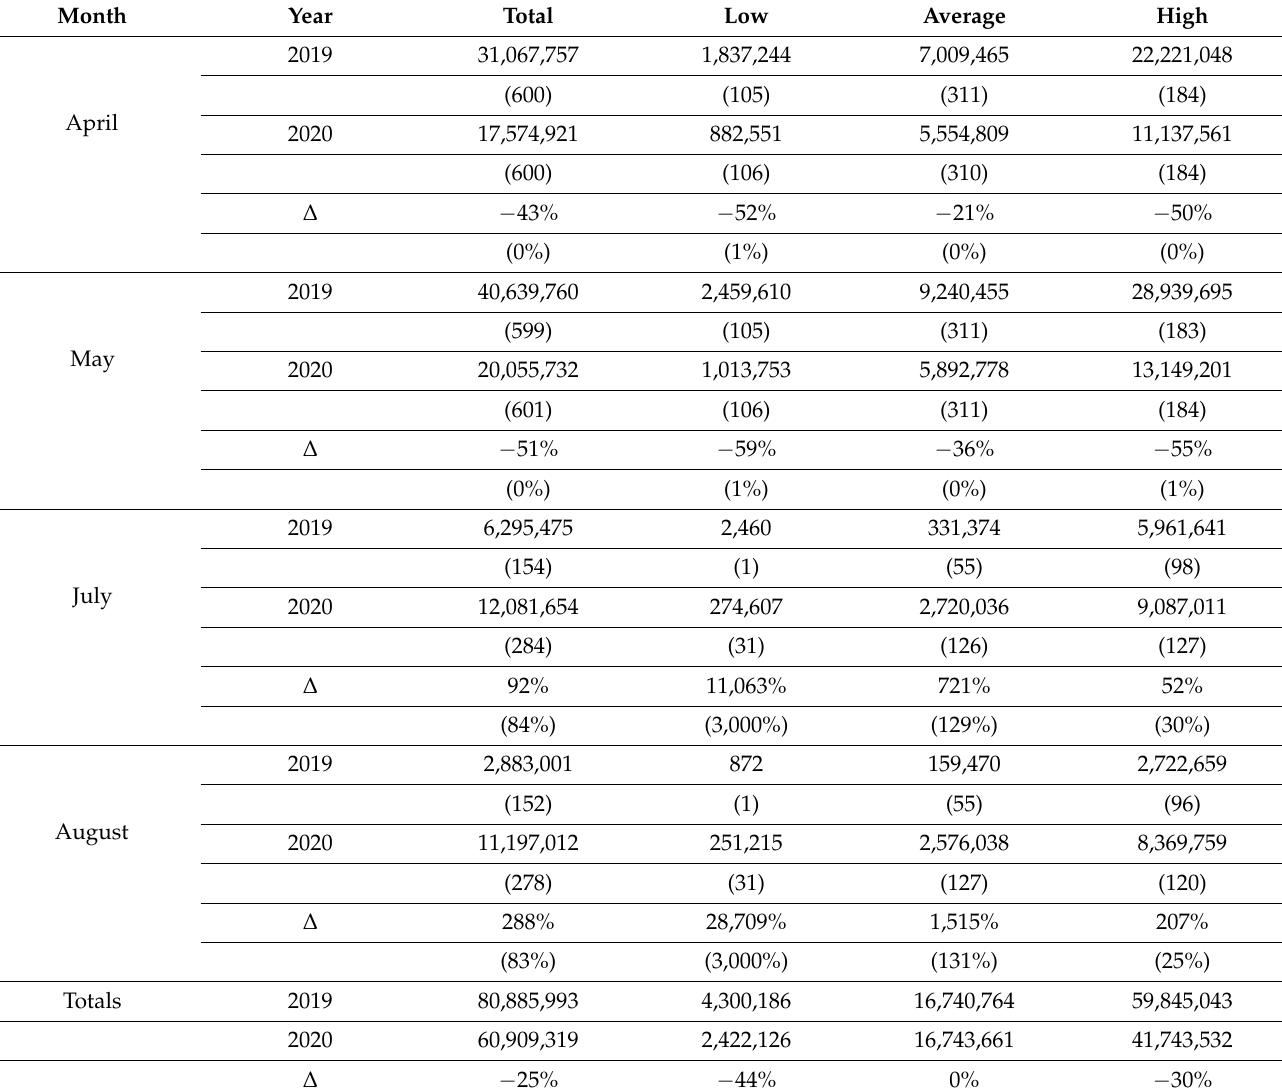
Table 1. Total meal count (SFA Count) and by need